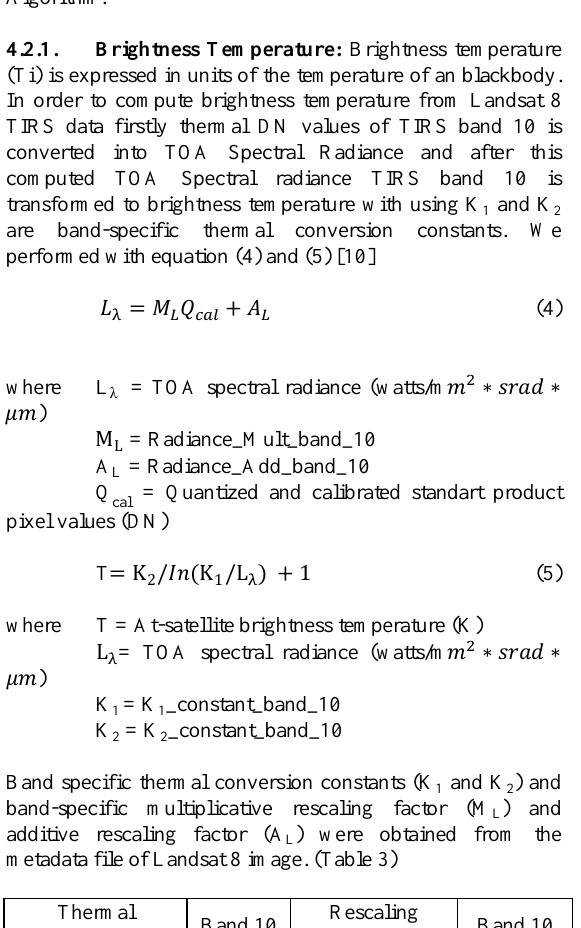
Figure 3. LST image was derived with Mono-window Algorithm.